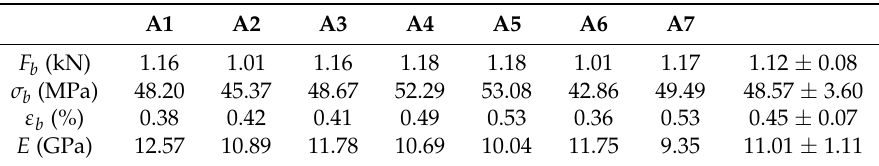
Table 4. Bending test results for annealed gres porcelain.